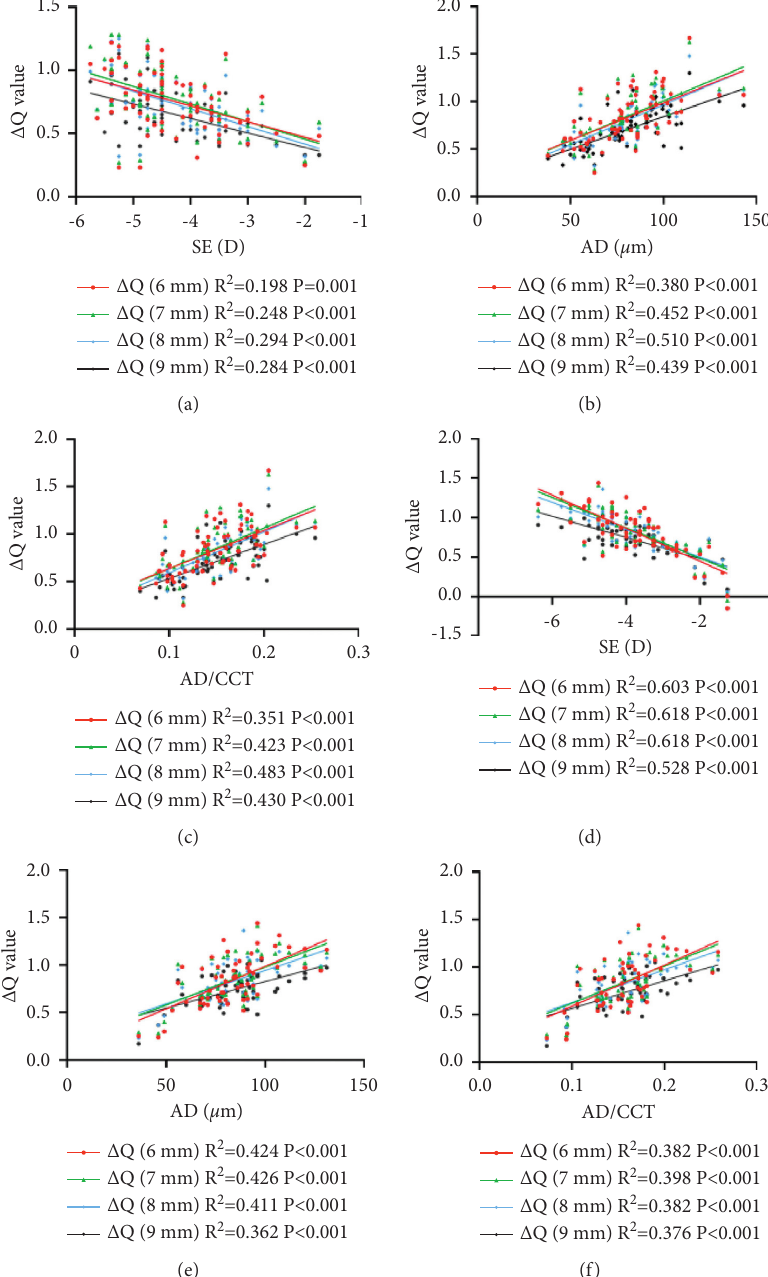
Figure 4: Correlation between the change in Q value and spherical equivalent (SE), ablation depth (AD), and the ratio of AD and central corneal thickness (AD/CCT) after the FS-LASIK (a–c) and Trans-PRK (d–f)